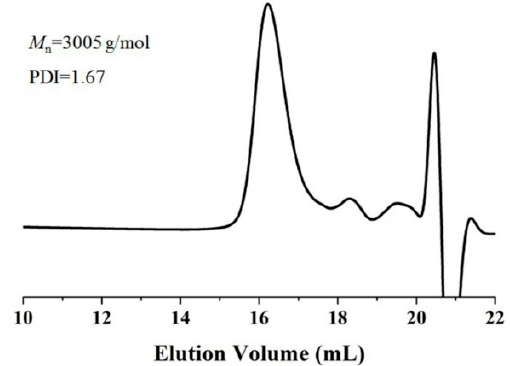
Figure 6. GPC chromatogram of PCL obtained in a gram-scale synthesis using immobilized enzyme EC-EP-AFEST. Reactions were conducted at 80 °C for 72 h, using 5 mL ε -caprolactone, 15 mL toluene and 2.0 g